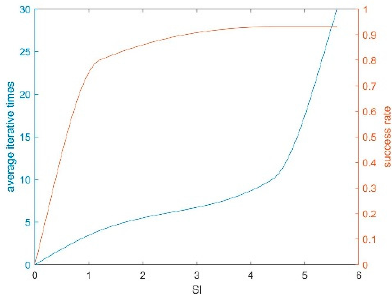
Figure 3. The trend of success rate and average iterative times on similarity index (SI).